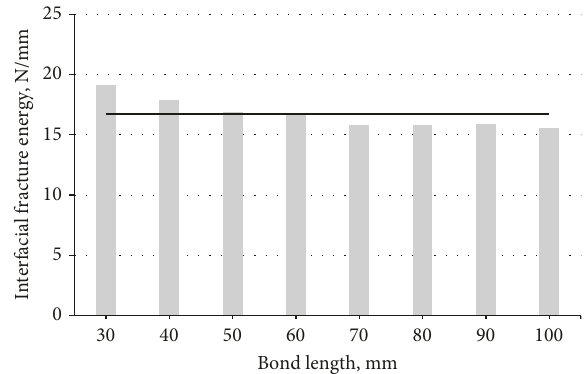
Figure 8: Interfacial fracture energy (G several experimental specimens—G f extracted from inverse analysis.